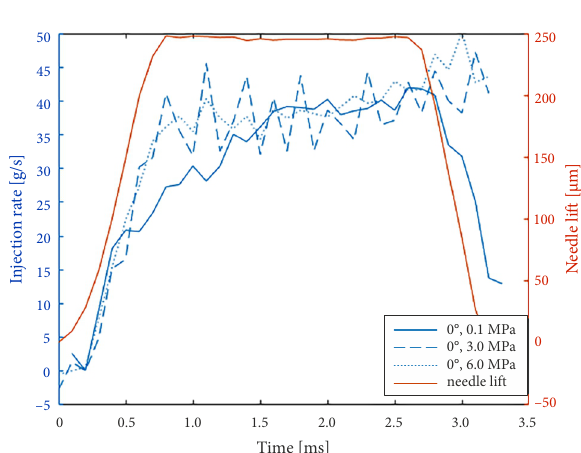
Figure 4. Measured injection rates and needle lift for 1400 min –1 , 400 N ⋅ m, 0° plug valve state, with different backpressures